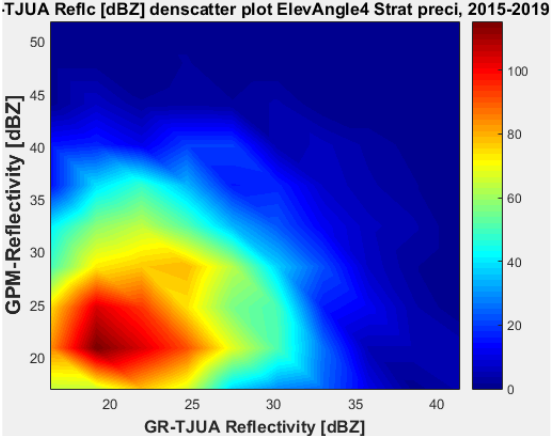
Figure 21. GPM ‐ Ka vs. NEXRAD TJUA for stratiform precipitation (angle 4).